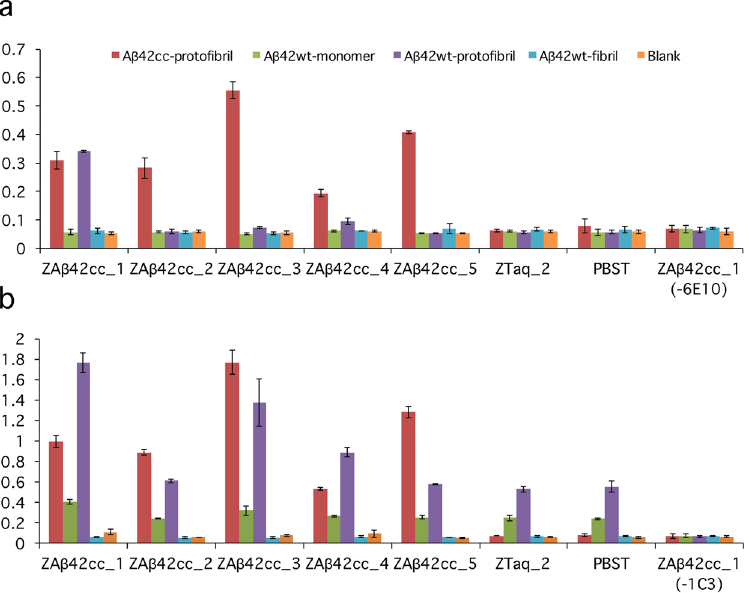
Figure 2. Binding profiling of five Affibody molecules to different A β aggregates, analyzed by ELISA. ( a ) A β 42 wt and A β 42 cc aggregates (50 nM assay concentration), bound to Affibody molecules, were detected by 6E10-HRP. 6E10 21 recognizes the N-terminus of A β . As expected, all five Affibody molecules show binding to A β 42 cc protofibrils. The Affibody molecule Z A β 42cc_1 also binds to A β 42 wt protofibrils. No binding could be observed to either wild type monomer or fibrils. ( b ) Same as in ( a ), except that the assay concentration of A β 42 was 1 µ M and mAb1C3 was used for detection (weakly specific for protofibrils 21 ). The binding profile has the same pattern as in ( a ) for protofibrils (both wt and cc) and A β 42 wt fibrils, but with a higher background for A β 42 wt protofibrils. ( a , b ) Two controls involve replacing the Affibody molecule with either an irrelevant Affibody molecule (Z Taq_2 ) or by PBS-T. In a third control experiment PBS-T was added instead of A β -specific antibody (6E10 or mAb1C3). Values are means of duplicate